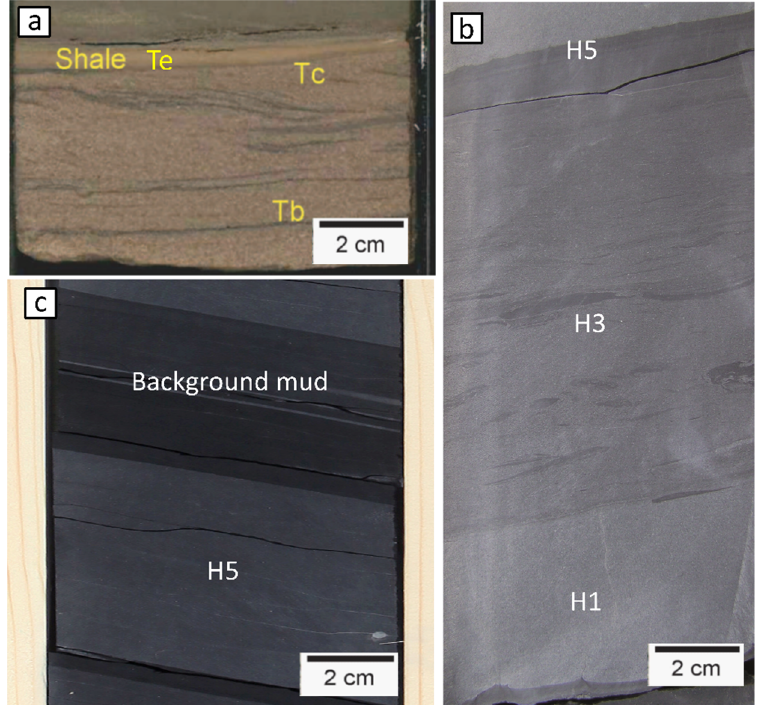
Figure 2. Core photographs showing ( a ) a low-density turbidite with organic-rich (average TOC = 8%) lower sandy divisions (Tb and Tc) and overlain by relatively organic-lean (average TOC = 2%) Te mudstone/shale from a Miocene deep-water succession of Kutei Basin, Indonesia [1]. Reprinted/adapted with permission from Ref. [1], 2006, AAPG; ( b ) Organic-rich H3 division (with 1.24 wt% TOC) of a hybrid event bed overlain by co-genetic H5 mudstone (with 0.6% TOC) from the Ross Sandstone Formation; and ( c ) vertically stacked H5 (0.7 wt% TOC) and background mudstone (0.6 wt% TOC) from the Ross Sandstone Formation, western Ireland.